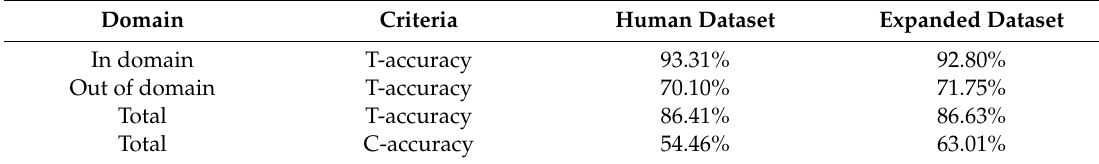
Table 6. Translation accuracy with auto-expanded training data. T-accuracy: translation accuracy, C-accuracy: classification